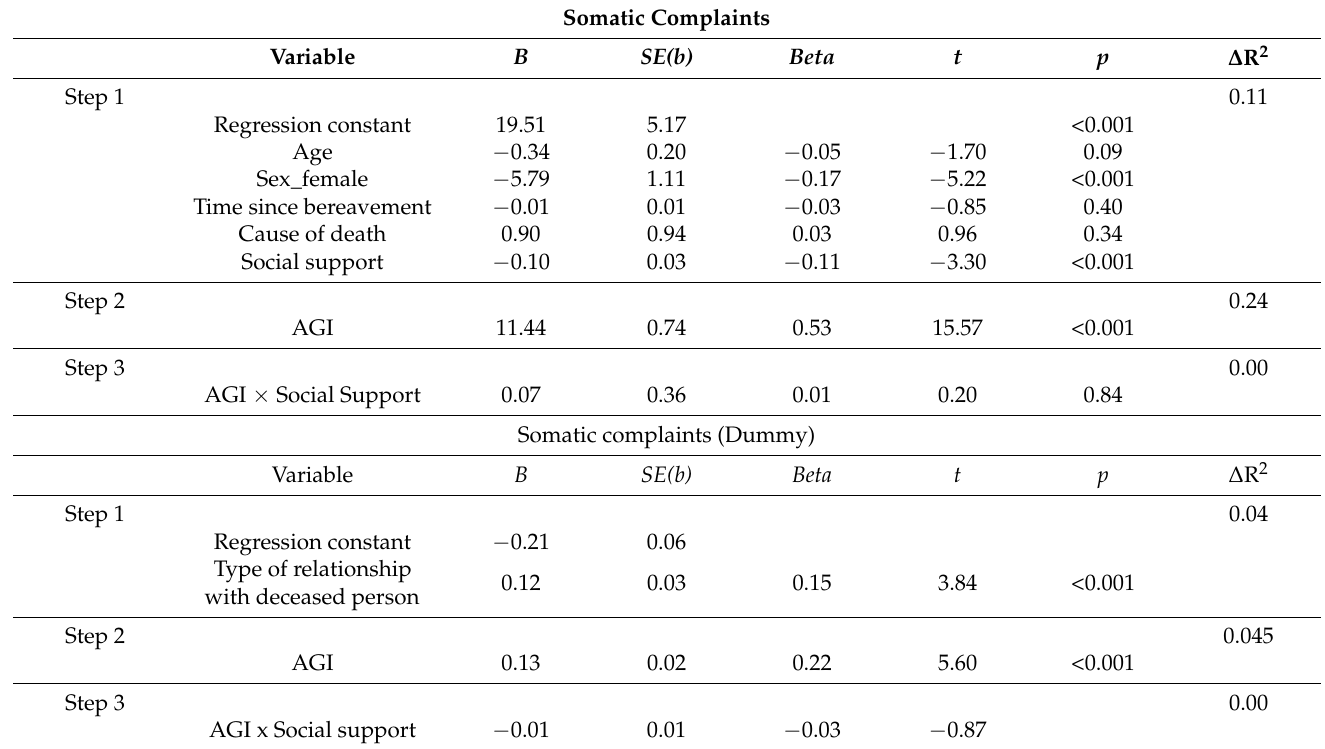
Table 2. Final Multiple Hierarchic Regression Analyses of Grief on Somatic Complaints (HGRC-PB).